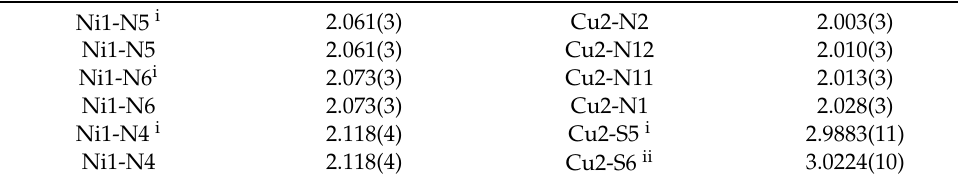
Figure 1. The local molecular structure of [{Cu(pn) 2 } 2 Ni(NCS) 6 ] n ·2nH 2 O ( 1 ) drawn at the 30% probability level. N4A, N5A and N6A denote symmetrically related thiocyanate anions. Table 2. Selected bond lengths [Å] for 1